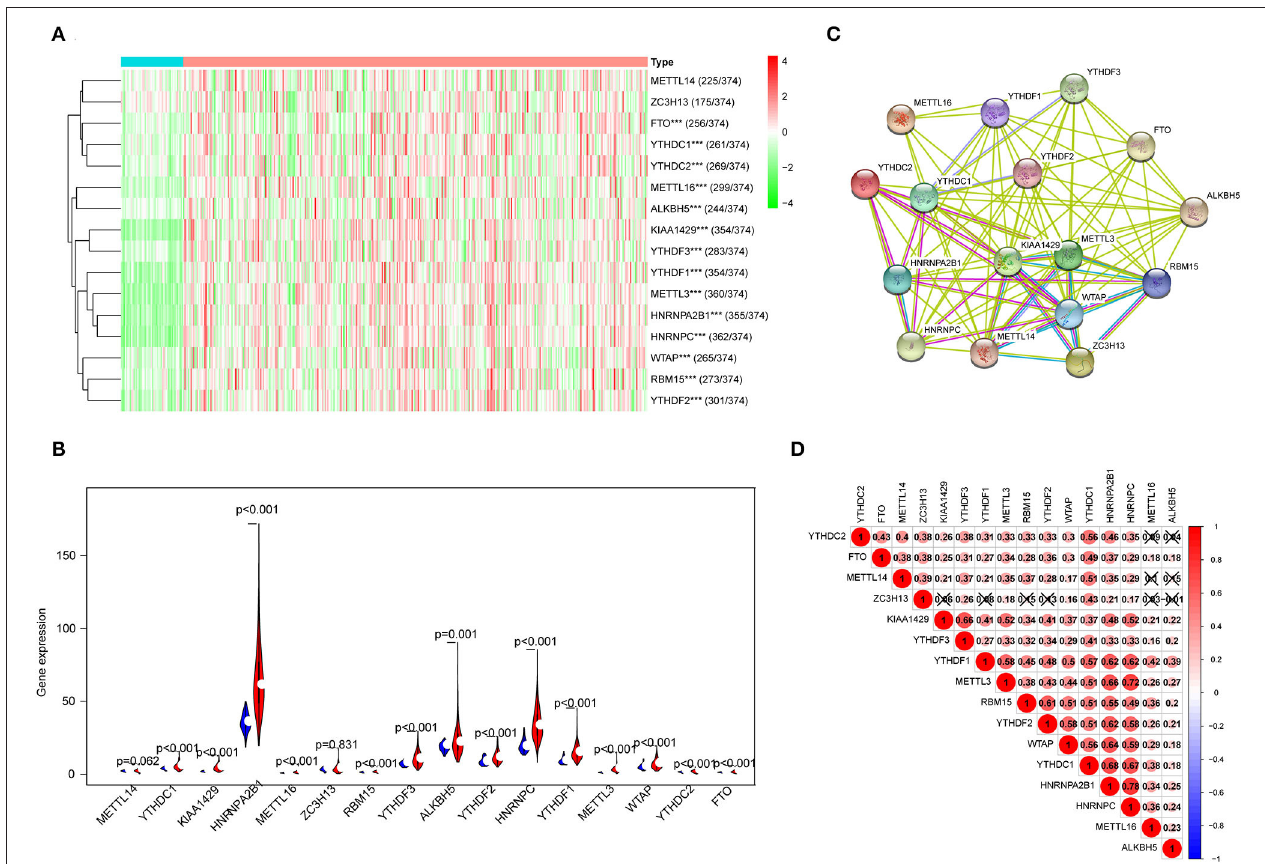
FIGURE 1 | The expression characteristics and correlations of N6-methyladenosine (m 6 A) RNA methylation regulators in hepatocellular carcinoma (HCC). (A) Heatmaps presented the overall expression of 16 m 6 A RNA methylation regulators in HCC tissues and normal liver tissues from The Cancer Genome Atlas (TCGA) datasets. (B) The differential expression of the m 6 A RNA methylation regulators was visualized by Vioplot (blue means normal liver tissues; red means HCC samples). (C) The interaction of the m 6 A RNA methylation regulators was analyzed by STRING. (D) Spearman correlation analysis of the 16 regulating genes in the liver hepatocellular carcinoma (LIHC) cohort. *** P <